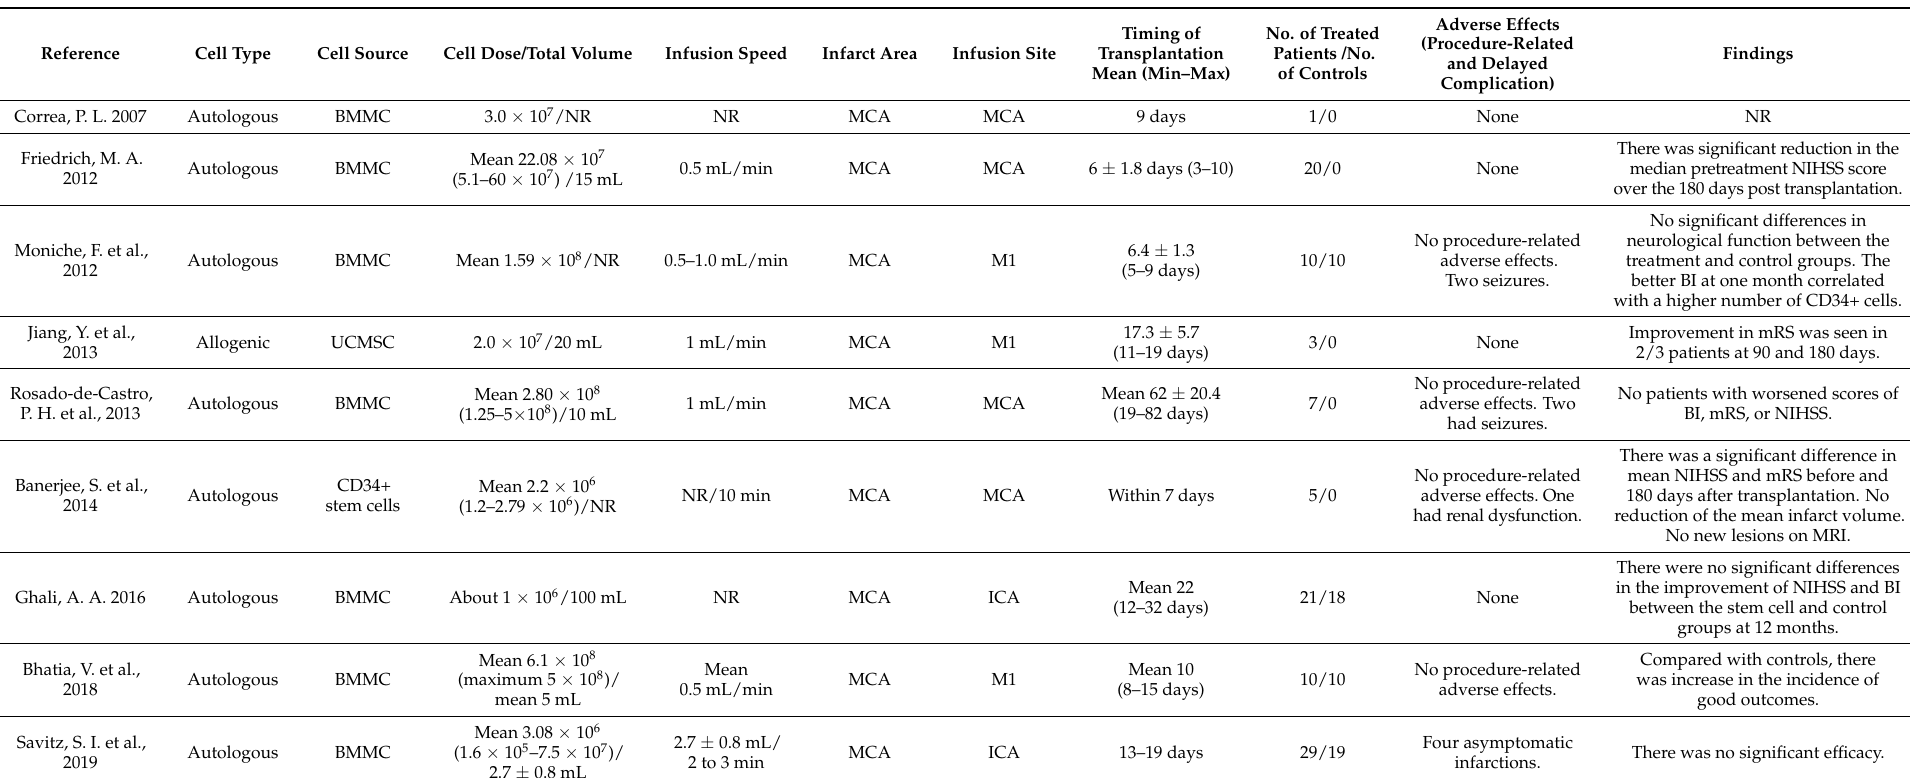
Table 1. Clinical studies of IA